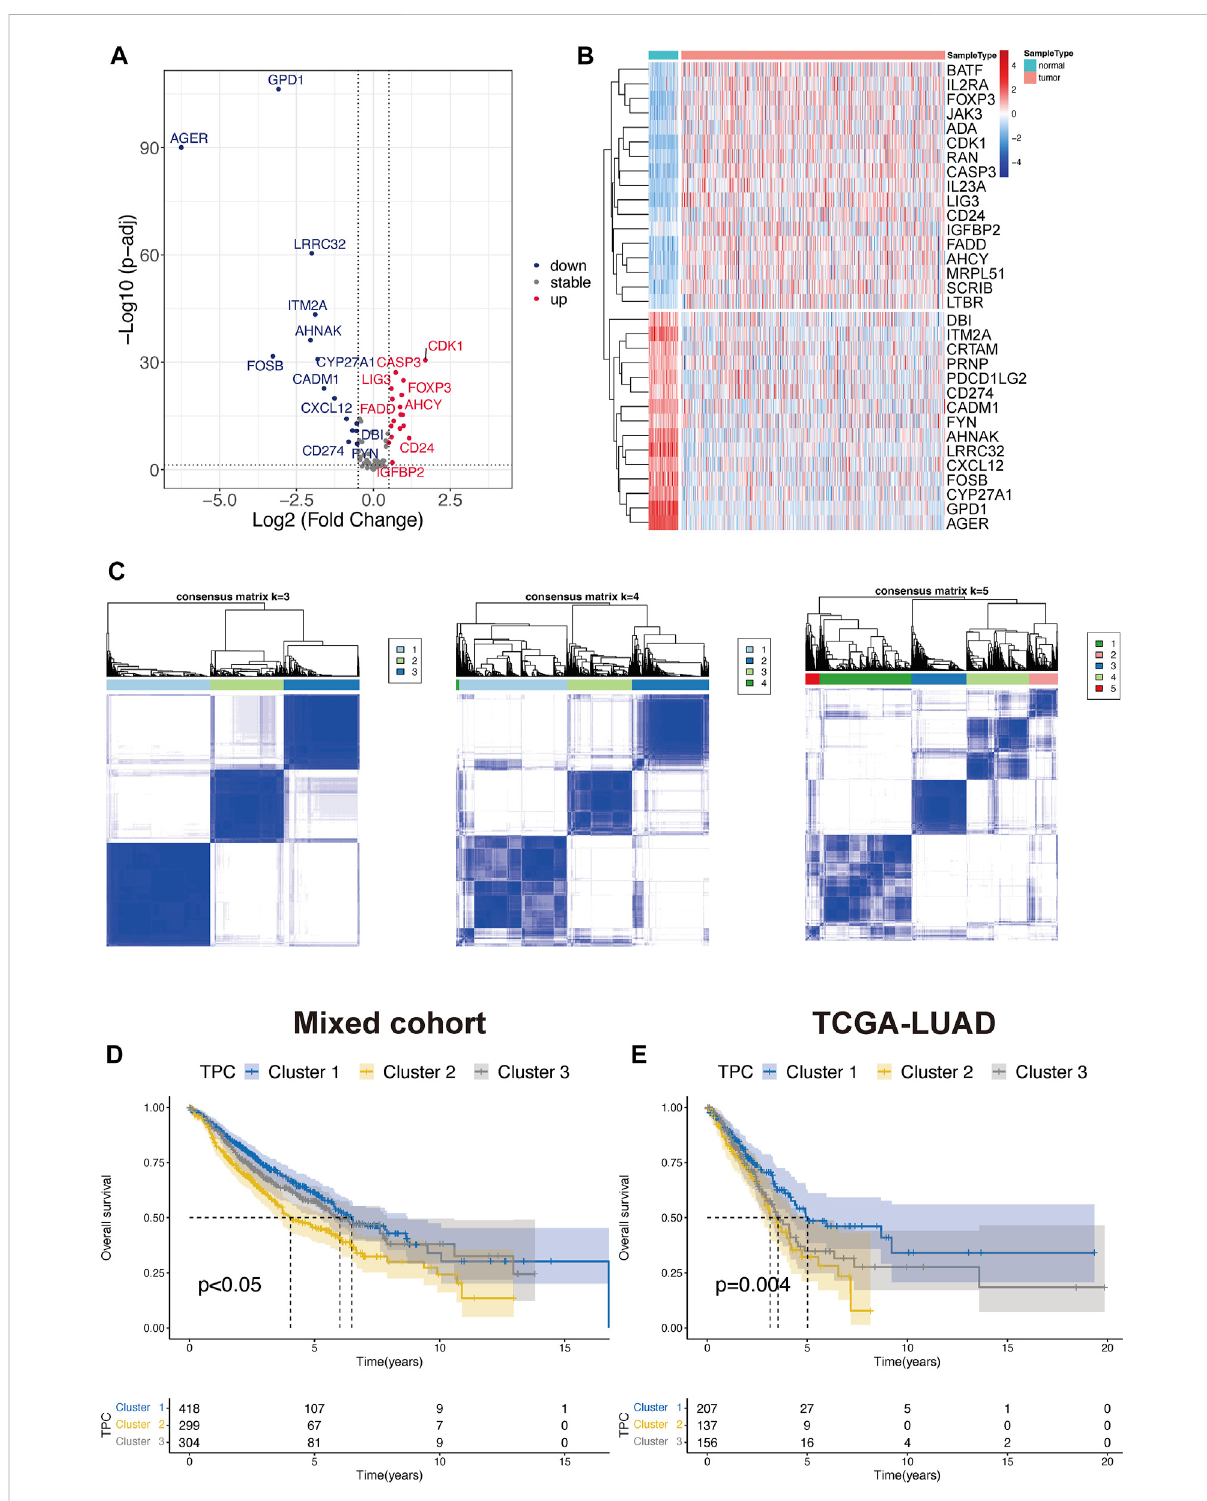
FIGURE 2 Identify the T cell proliferation cluster (TPC). (A,B) Volcano diagram and heatmap of the positive drive of T cell proliferation that depicts the abnormaldifferentiallyexpresspatterninlungadenocarcinomaandnormaltissuesamples.Bluedots:down-regulation,greydots:nonesigni fi cance differential genes, and red dots: up-regulation. (C) Unsupervised hierarchical analyses of the differential expression patterns of these T cell- associated genes in mix-cohort (k-means = 3 – 5). (D,E) Comparison of overall survival between TPC by using Kaplan-Meier survival curves in mix-cohort (D) and TCGA-LUAD (E)